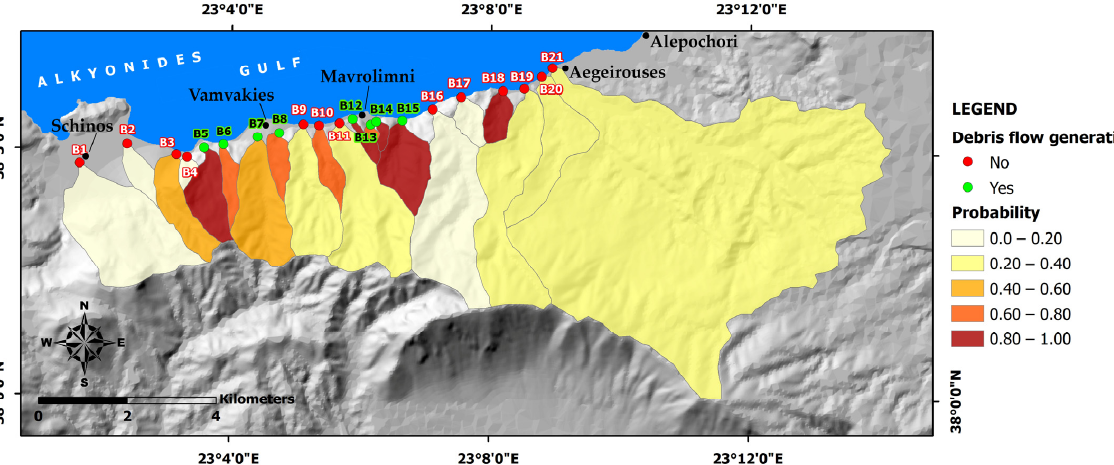
Figure 8. Map of the study area, showing the calculated probability of debris flow occurrence in five categories, against the actual debris flows (DB) generation during the 21 December storm in the area. The names B1 to B21 represent the codename of each basin.